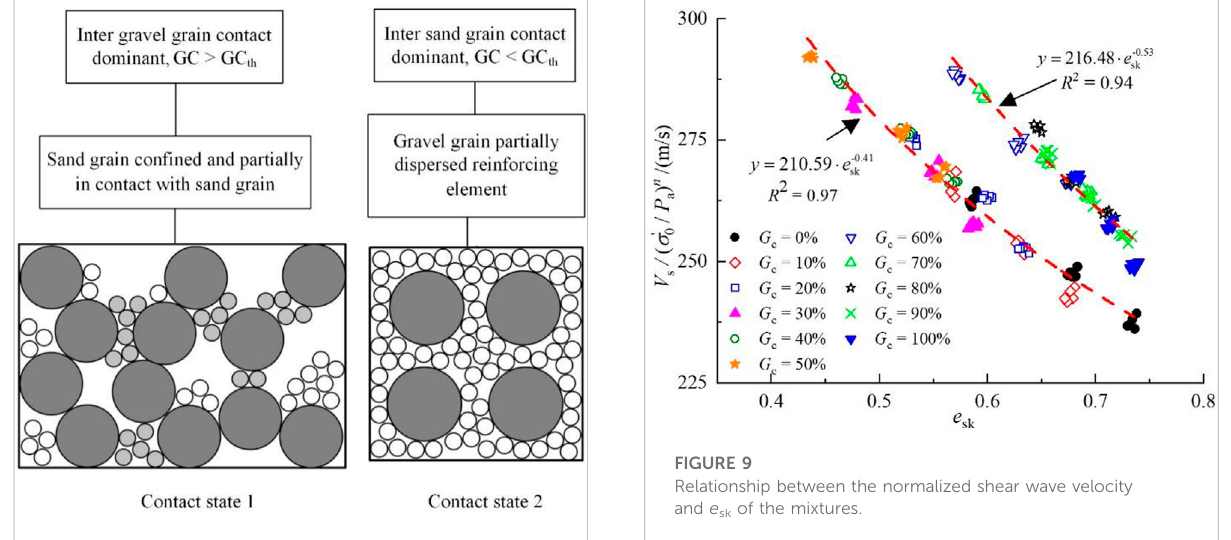
FIGURE 8 Intergranular contact states of the mixtures.